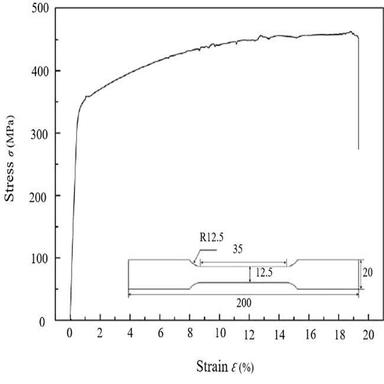
Stress–strain curve for AA2024-T3 specimen.